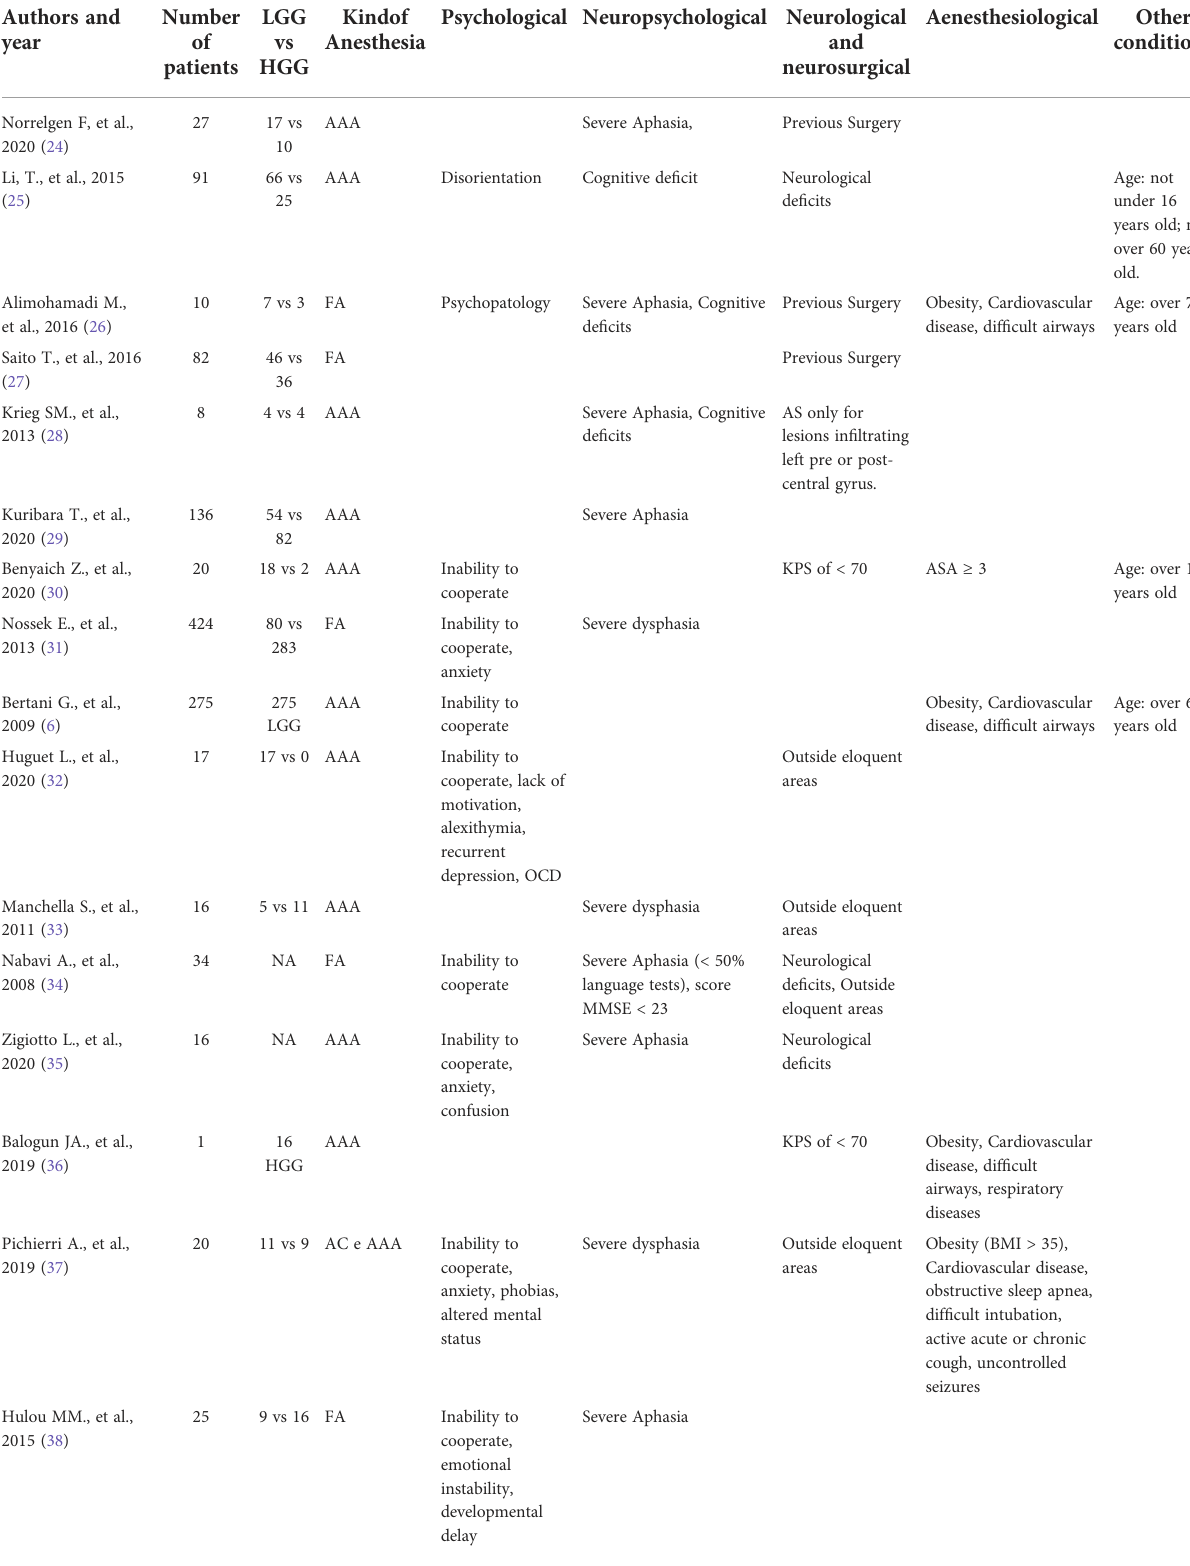
TABLE 1 Main characteristics of the studies, including relative inclusion and exclusion